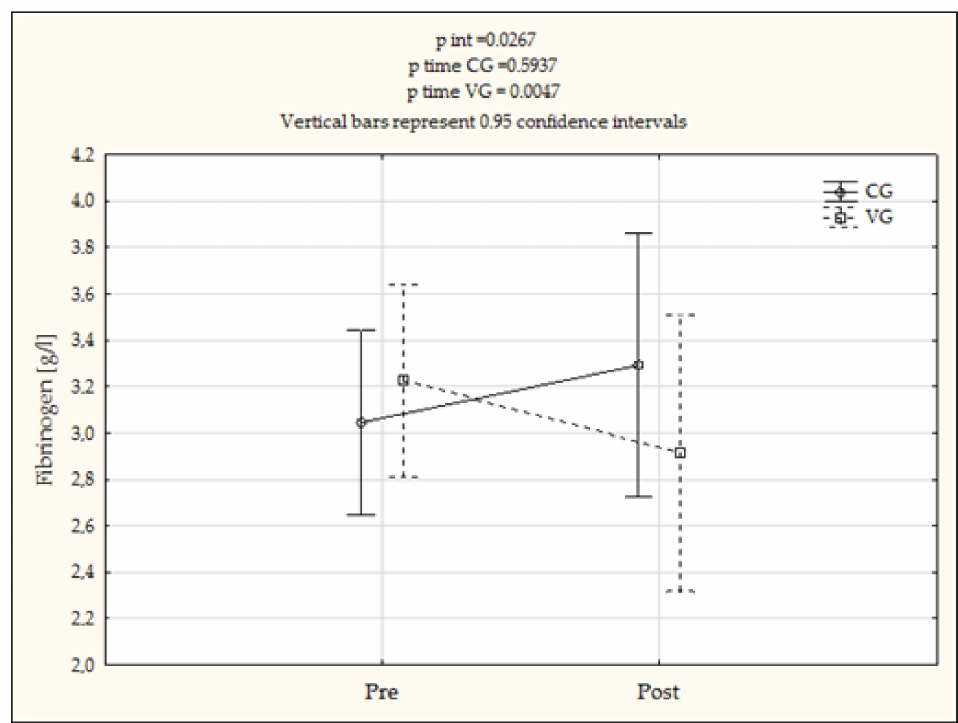
Figure 2. Mean concentrations of fibrinogen (g/L) in the control group (CG) and the examined group (VG) before (pre) and after (post) three-month-long vibrotherapy, considering interactions between groups ( p int) and changes over time ( p